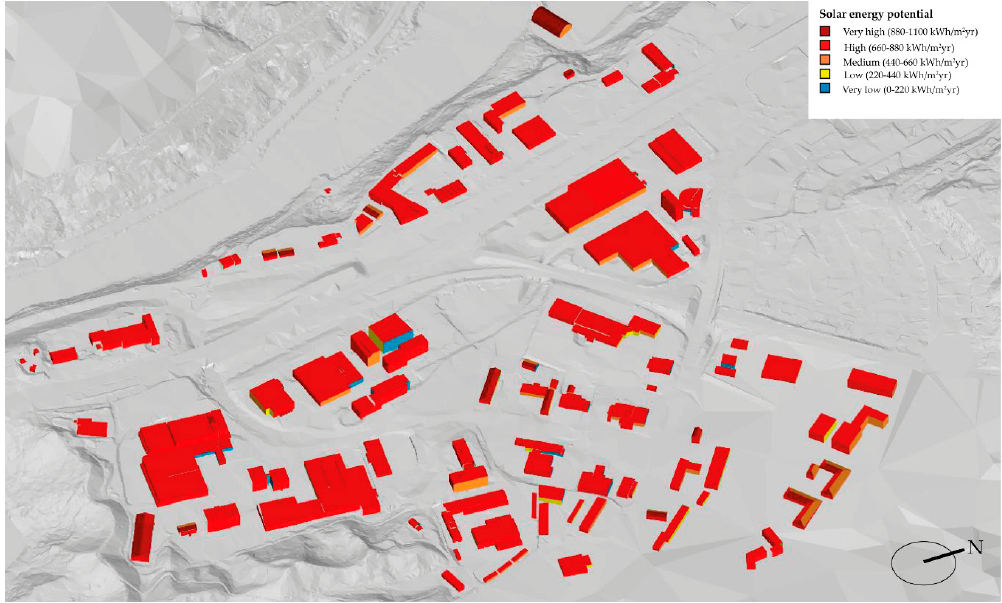
Figure 12. Three-dimensional visualization of the solar map for the existing situation.